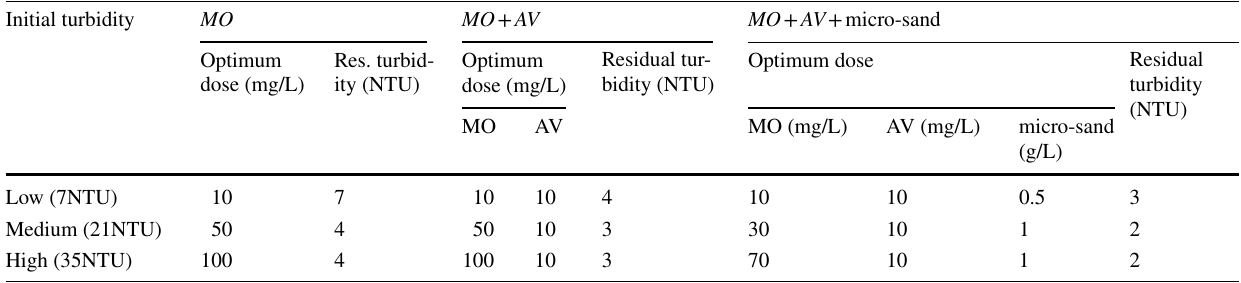
Table 1 Turbidity removal by Moringa oleifera (MO) with and without Aloe Vera (AV) ; ballasted coagulation by MO , AV , and micro-sand Initial